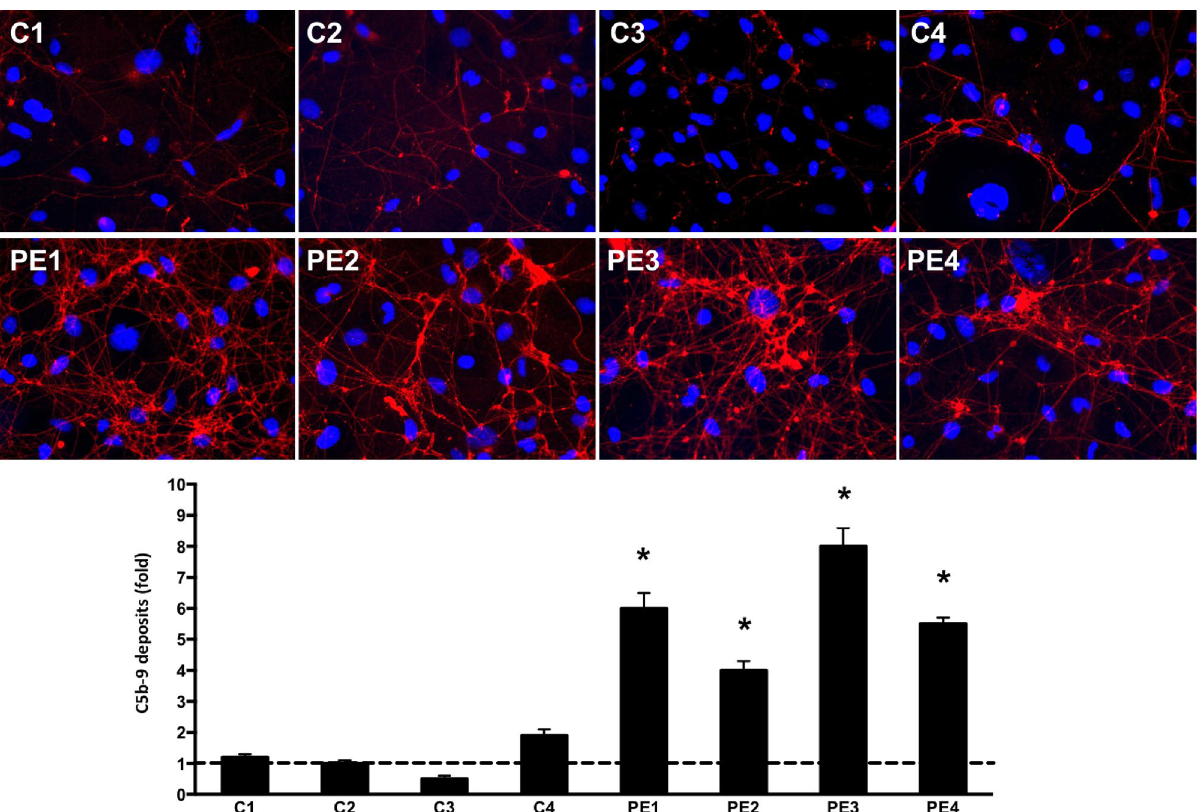
Figure 4. Representative microphotographs of the C5b-9 deposits (red) on endothelial cells in vitro (blue- labeled nuclei) induced by incubation with plasma from healthy pregnancies (controls, n = 4) and pregnancies complicated by preeclampsia (PE, n = 4). The bar chart represents the quantification of C5b-9 deposits. Whiskers represent the mean ± standard deviation. All the controls samples are within the normal range whereas the four pregnant women with PE show significant complement activation (*p < 0.05).